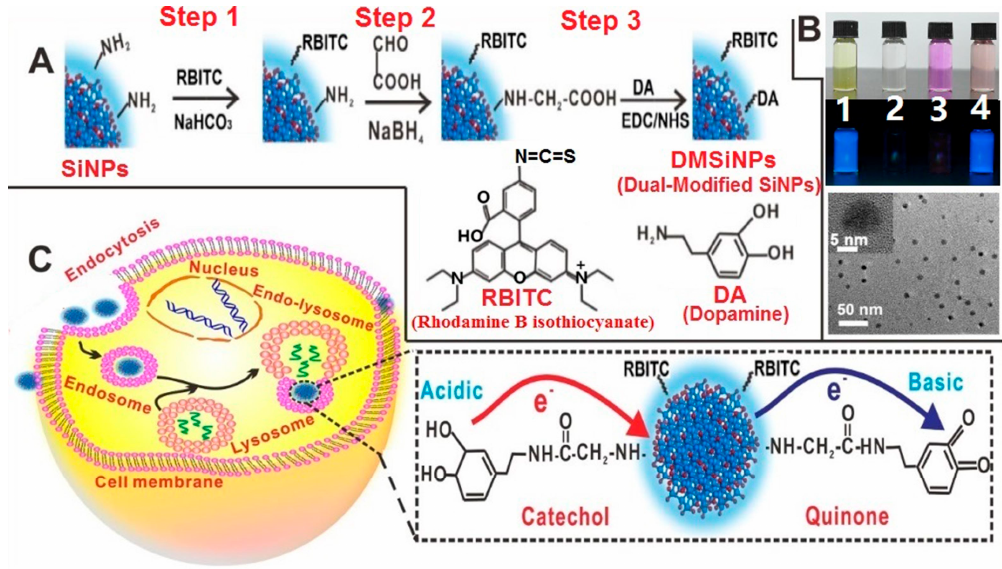
Figure 6. Construction of SiNP-based intracellular pH sensor. ( A ) Schematic illustration of the synthesis of sensor; ( B ) photos of SiNPs (1), dopamine (2), rhodamine B isothiocyanate (RBITC) (3), and modified SiNPs (4) in ambient environment and under UV irradiation ( λ ex = 360 nm) as well as TEM image of dual-modified SiNPs (DMSiNPs). Inset shows the enlarged HRTEM image of a single DMSiNP; ( C ) schematic illustration of cellular internalization of DMSiNPs. Inset in part C presents